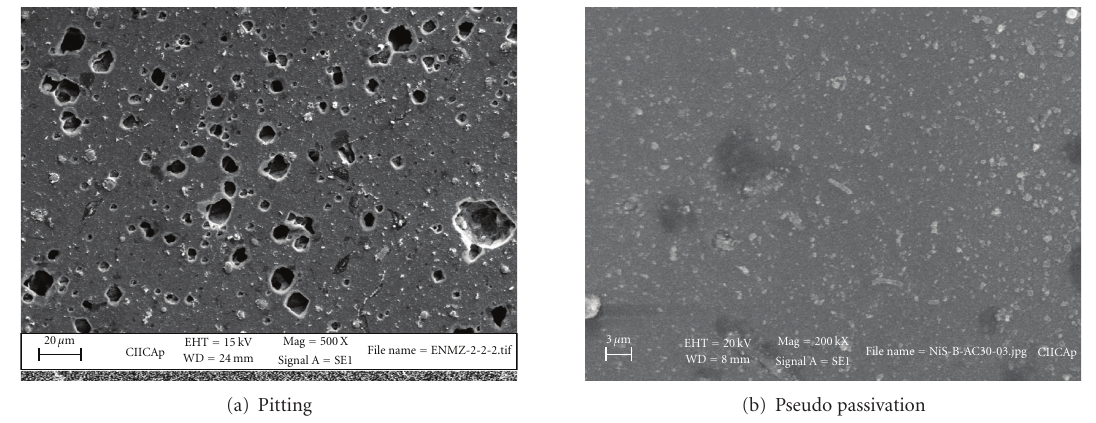
Figure 2: SEM micrograph showing morphology attack.